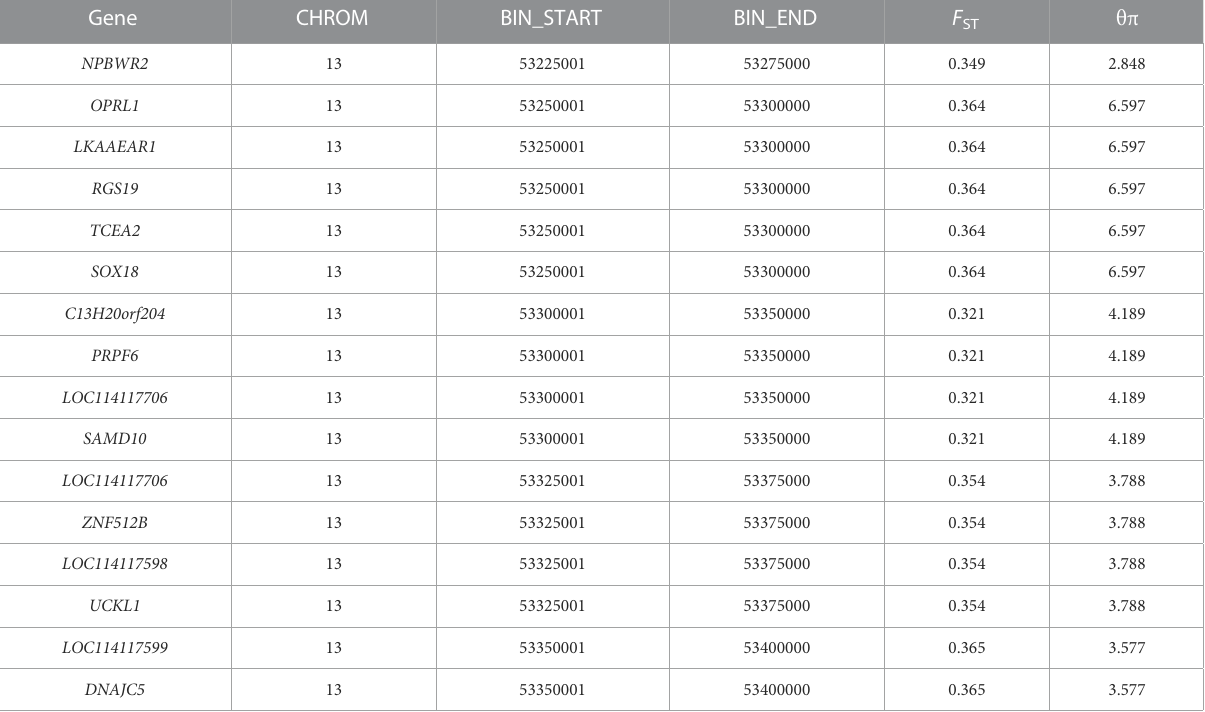
TABLE 4 Genes annotated in the 53.2 – 53.4 Mb region of chromosome 13.